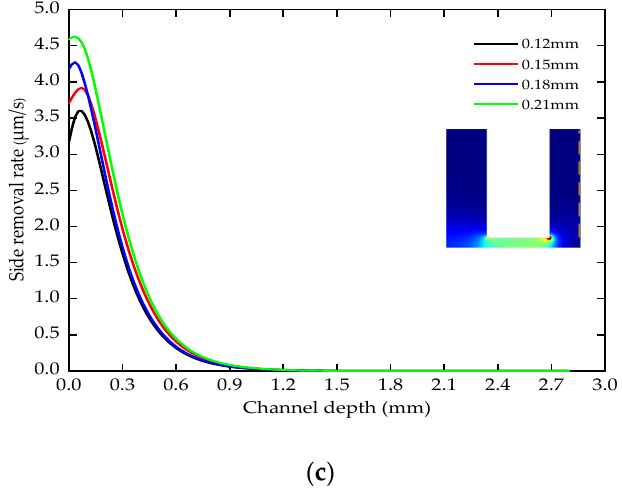
Figure 10. The temperature, current density and side removal rate of various lateral gaps; ( a ) the change of the temperature; ( b ) the change of the current density; ( c ) the change of the side removal rate.